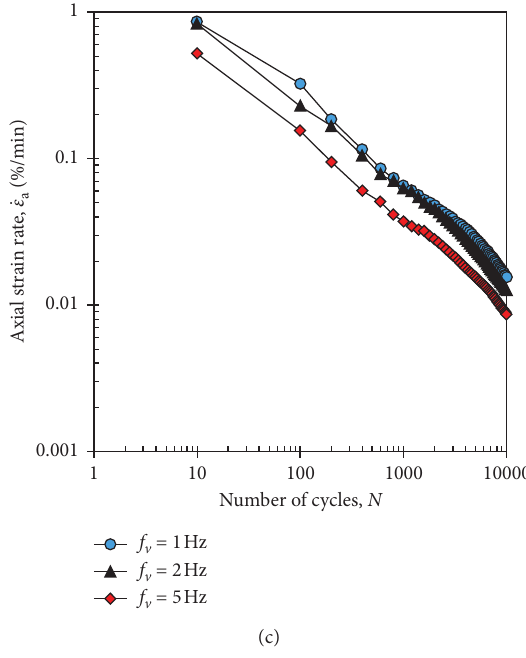
Figure 14: Variation of ε ̇ a with N at f c of (a) 1Hz, (b) 2Hz, and (c)